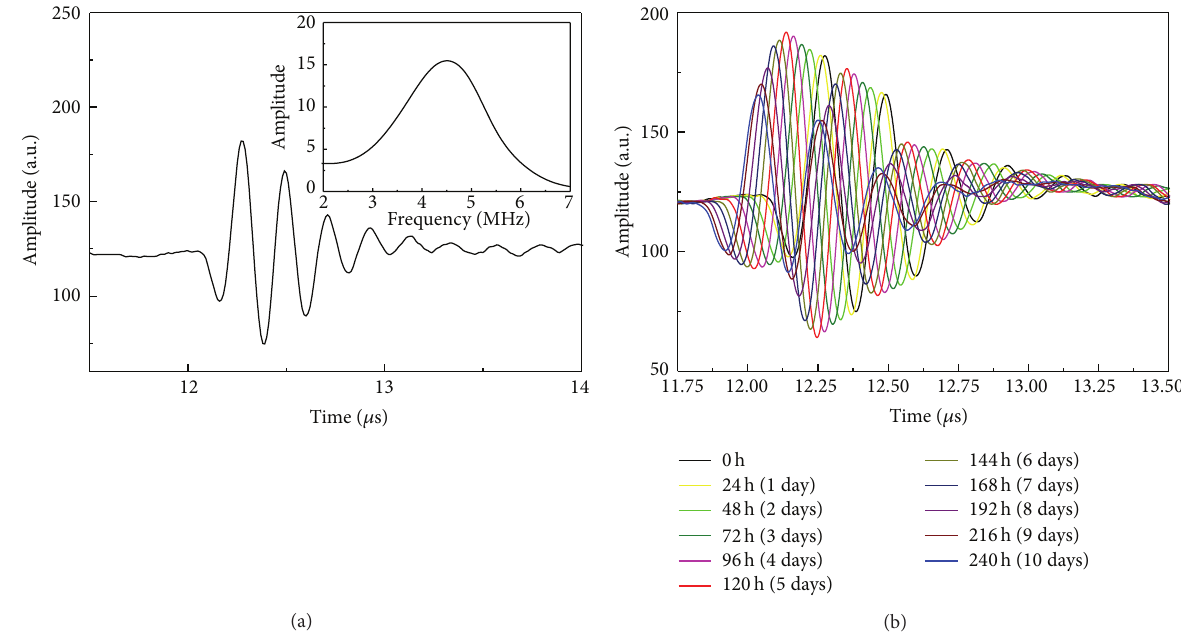
Figure 5: (a) The typical time domain received signal with the corresponding frequency domain spectrum (inset) and (b) the changes of signal recorded for 10